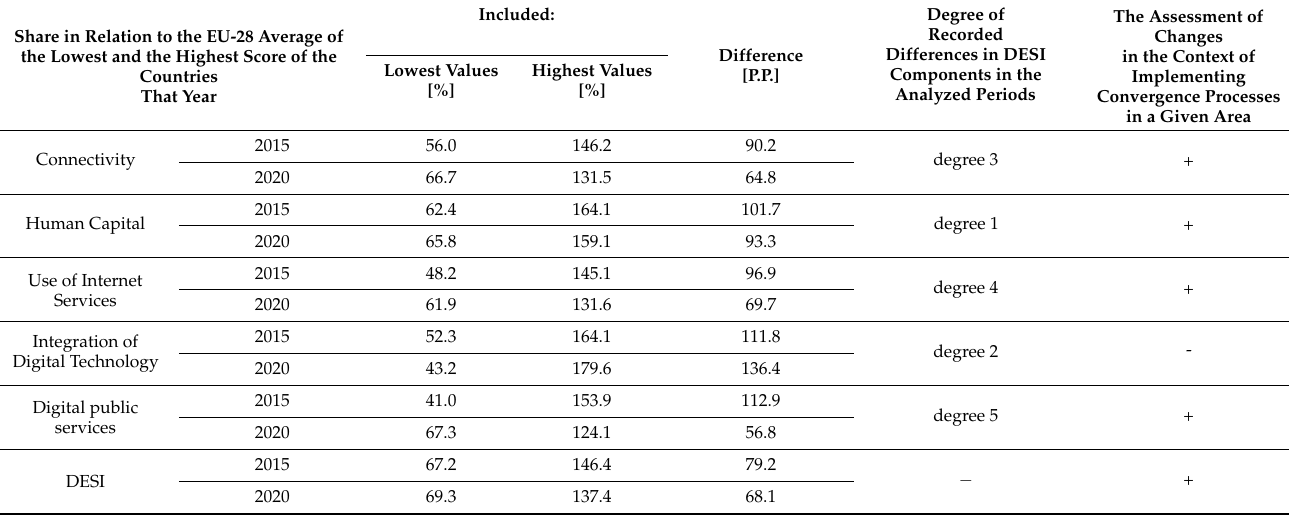
Table 1. Data summary and evaluation of the obtained values in terms of DESI measures and its sub-indicators for the countries with the lowest and the highest values in relation to the EU average in 2015 and 2020. Source: Our own study. Share in Relation to the EU-28 Average of the Lowest and the Highest Score of the Countries That Year